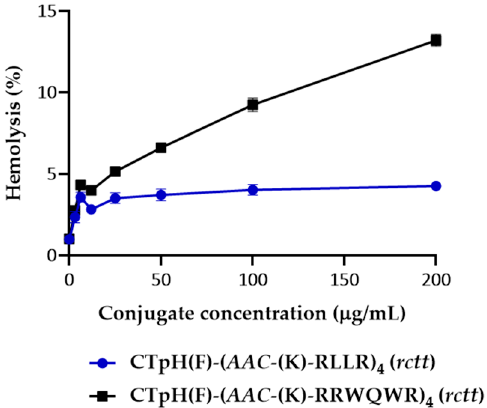
Figure 6. Hemolytic activity of (peptide) 4 -resorcinarene derived from LfcinB (20–25) and BF (32–35).